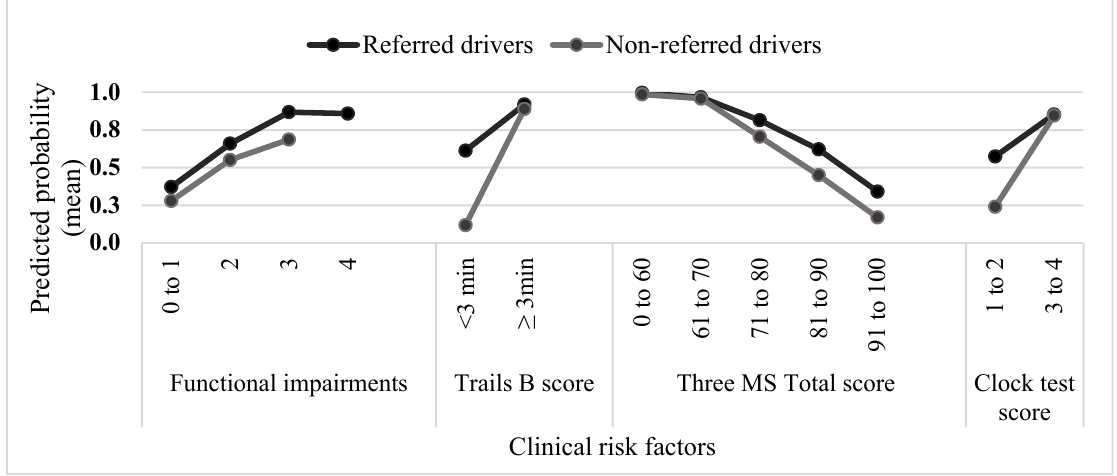
Figure 1. Mean predicted probability of being referred to driving authority for different clinical risk factors. Table 4. Typology of iADL decline, stratified by referral